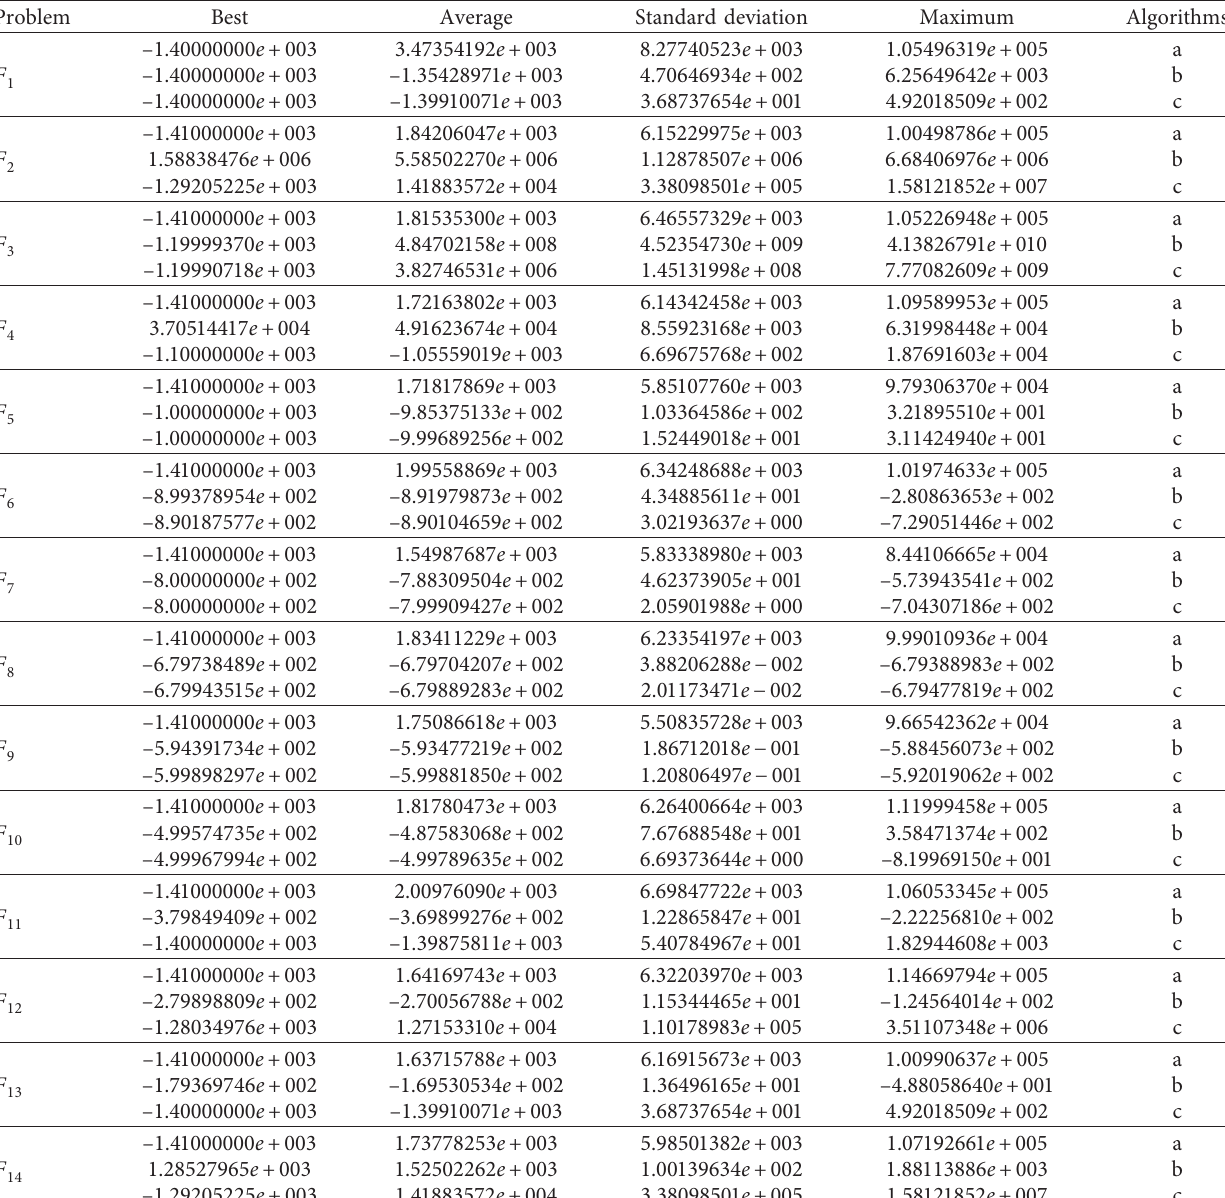
Table 6: The experimental results of (a) MSIA, (b) ACO, and (c) FA for CEC ′ 13 benchmark functions in 50 dimensions [54].